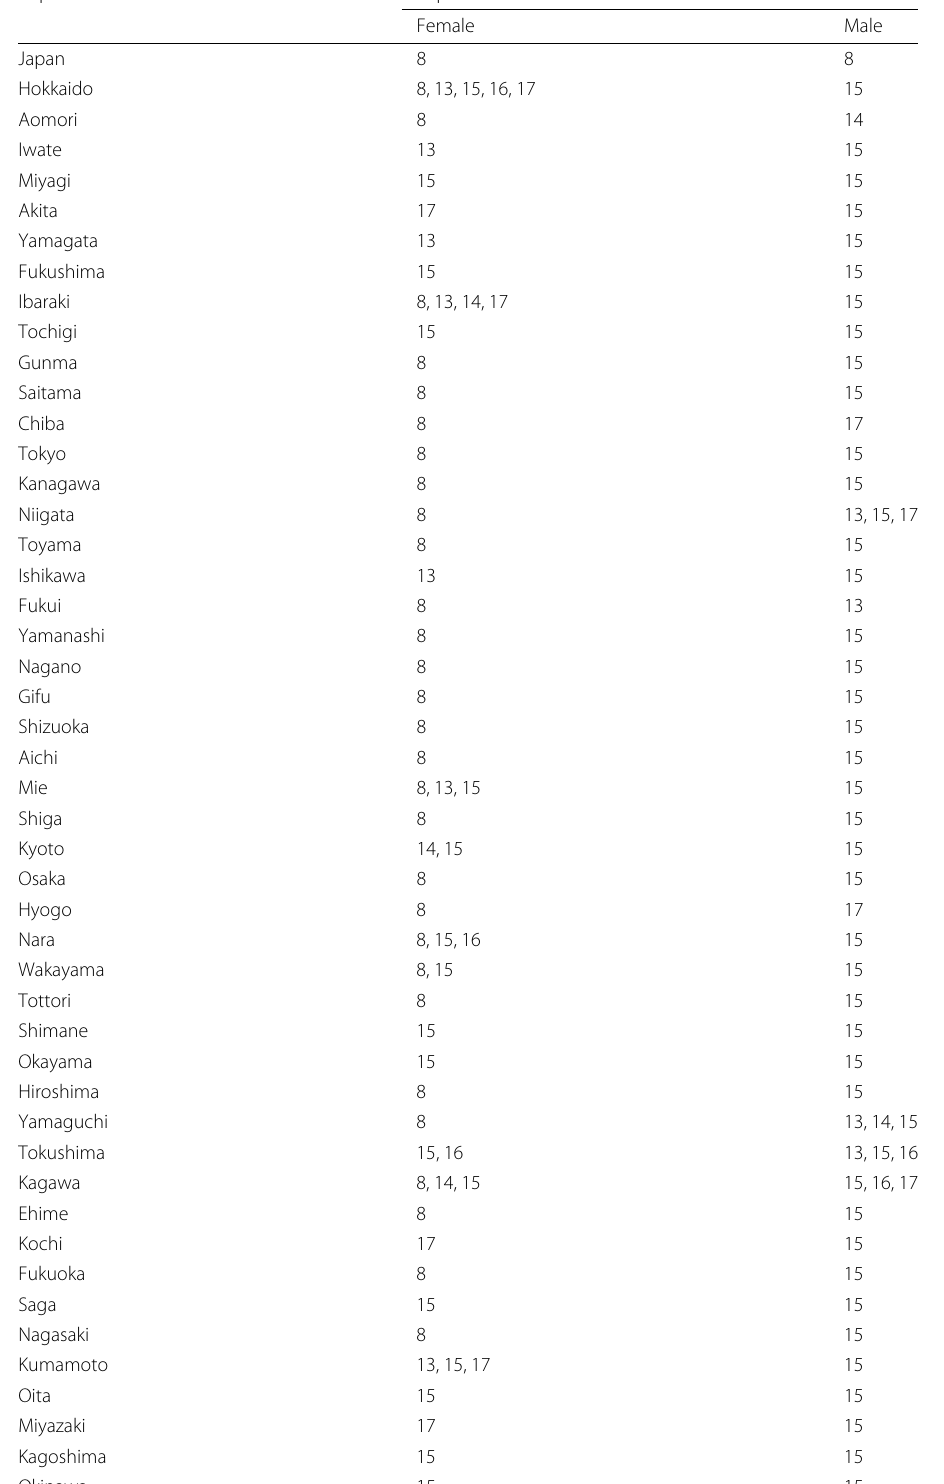
Table 5 MCS procedure using the T R,M test applied to the mean interval score in the validation set from 1996 to 2005 for forecasting the Japanese female and male national and sub-national mortality rates for ages between 60 and 100+ Population Superior